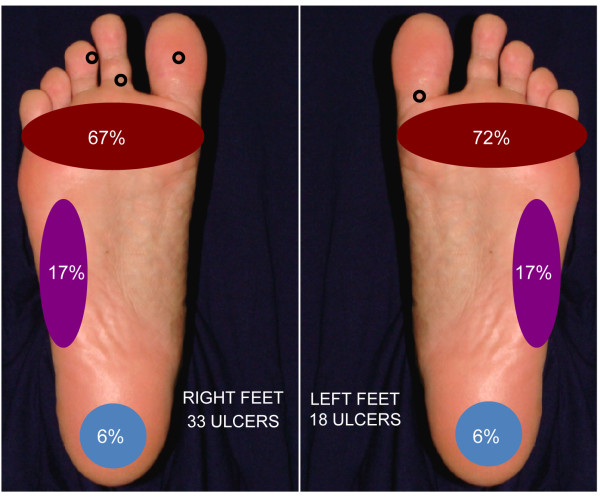
Anatomic distribution of the ulcers on the plantar region. Of 51 plantar ulcers, 33 were on right feet and 18 were on left feet. Ulcers were more common on the areas of the sole that bear weight during walking and standing. The little black circles indicate isolated lesions that were not included in the pictured percentages.